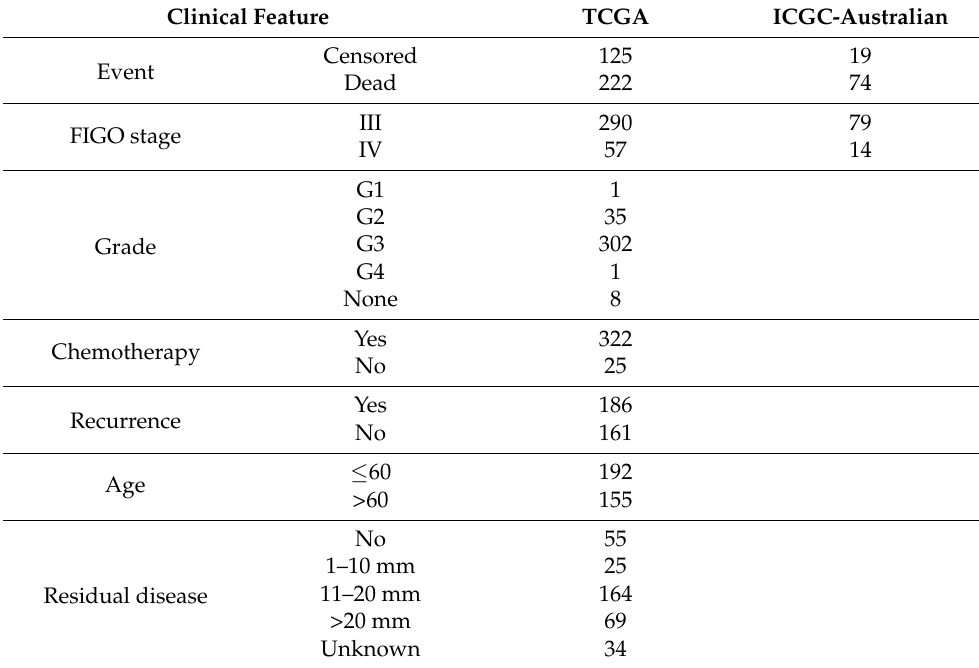
Table 1. Sample information from The Cancer Genome Atlas (TCGA) and International